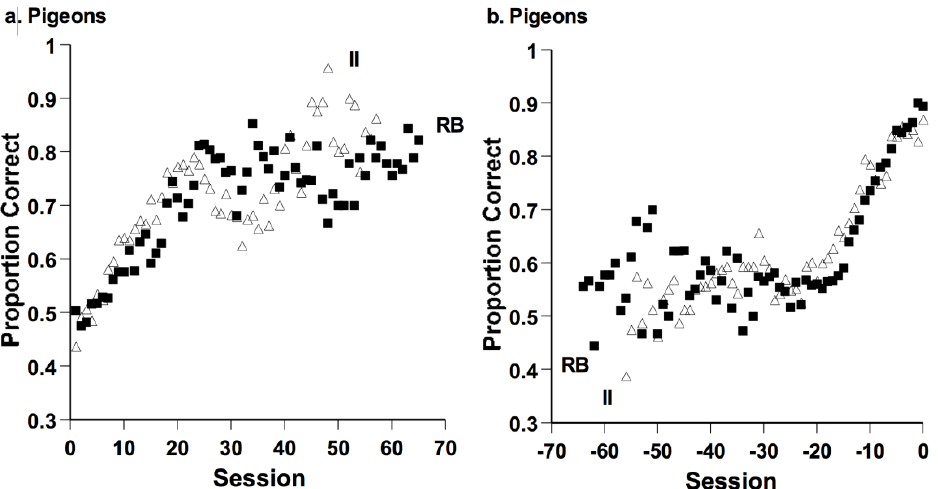
Figure 14. Pigeons performing information-integration (II) and rule-based (RB) tasks. (a) Proportion of correct responses in each session from the onset of learning forward for eight II-learning pigeons (open-triangle symbols) and eight RB-learning pigeons (filled-square symbols); (b) proportion of correct responses in each session from the criterial block backward for eight II-learning pigeons and eight RB-learning pigeons. Reprinted from [58]. Copyright 2012 by Elsevier. Reprinted with permission.